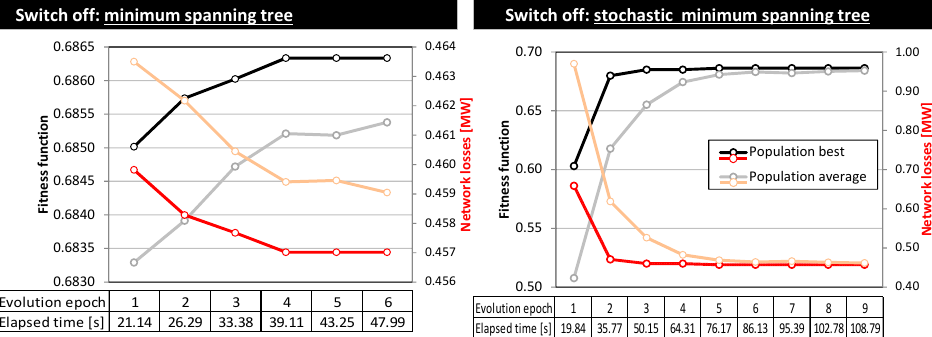
Figure 10. Convergence rate for different switch-off approaches—for 880 bus network.